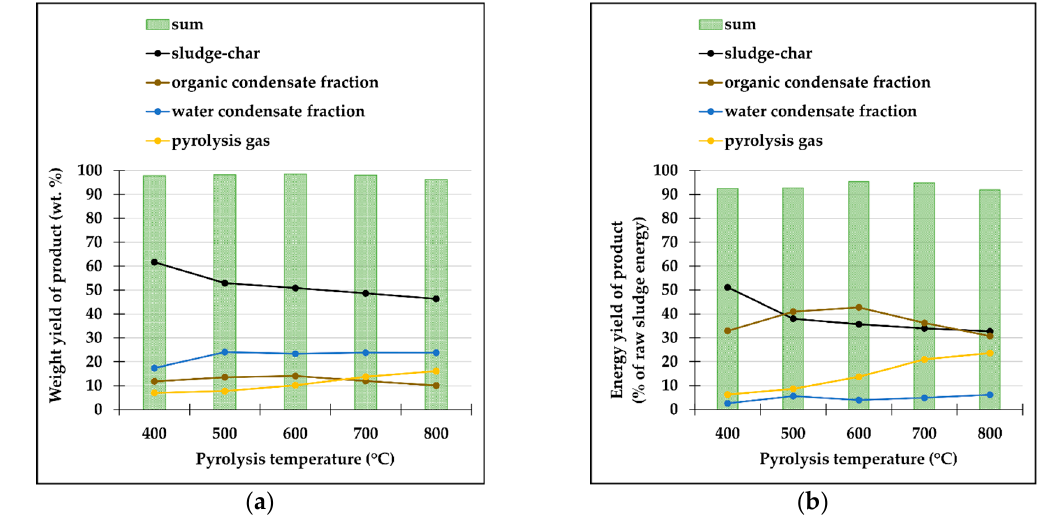
Figure 2. ( a ) Mass balance of the sludge pyrolysis at temperatures from 400 to 800 °C ( b ) Energy balance of the sludge pyrolysis at temperatures from 400 to 800 °C.